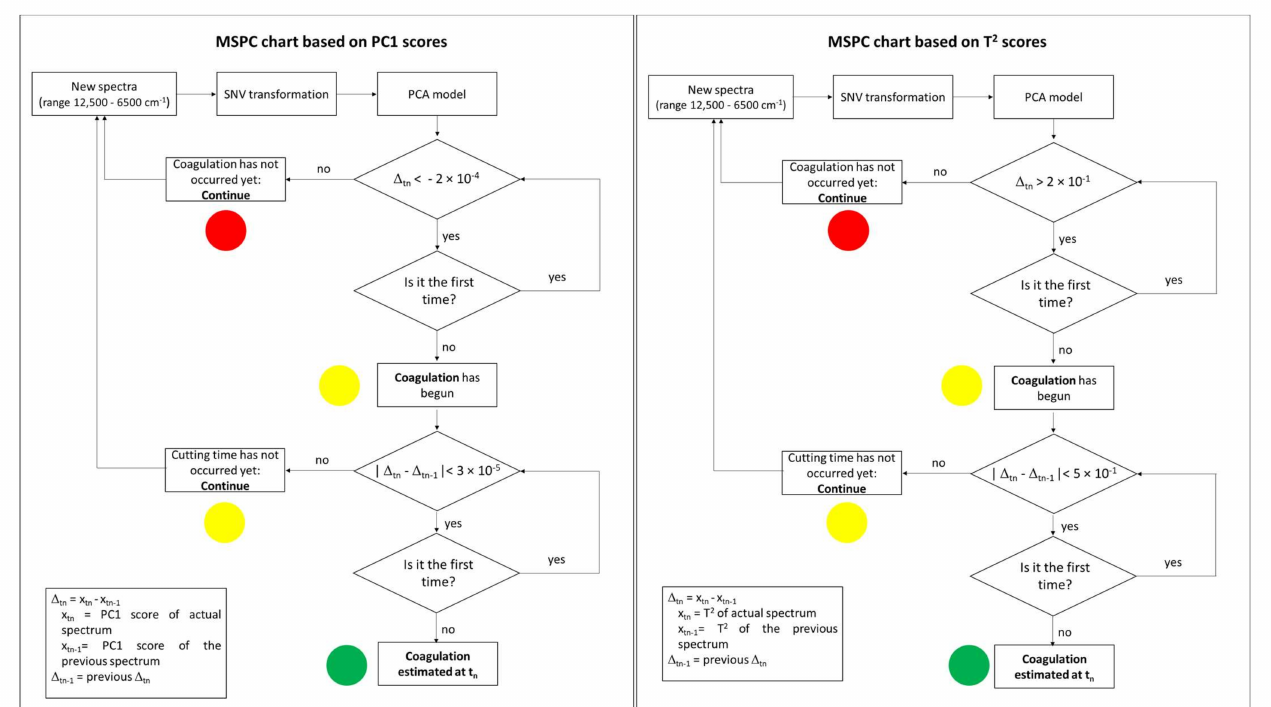
Figure 6. Process decision trees for real-time coagulation control from MSPC charts based on PC1 scores and T 2